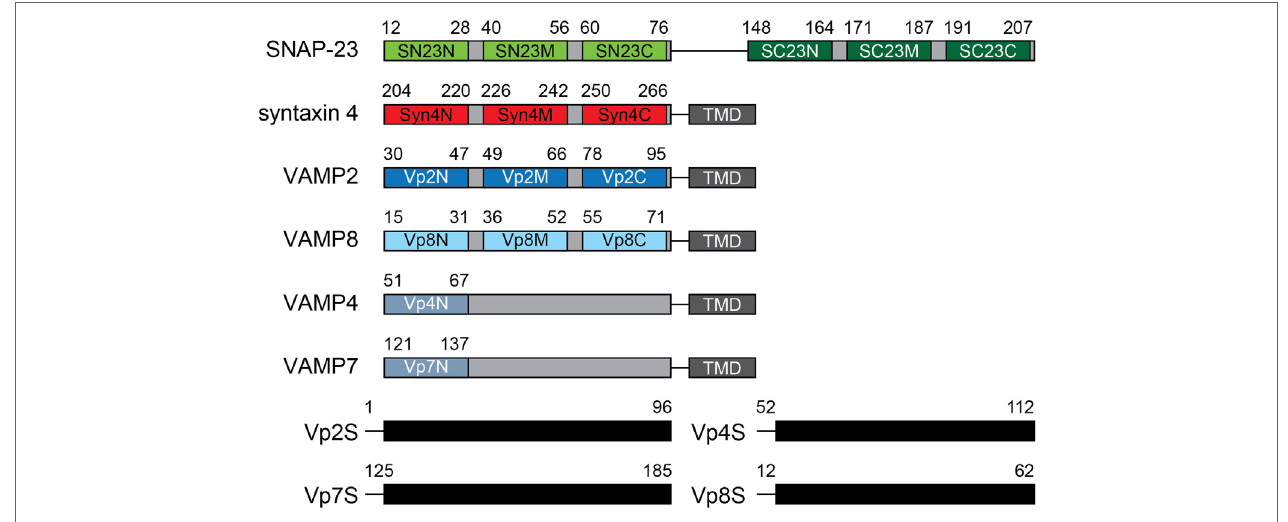
FigUre 1 | Design of mast cell soluble N -ethylmaleimide-sensitive factor attachment protein receptor (SNARE) motif-patterned peptides. Peptides patterned after the α -helical regions of the SNARE motifs of SN23 (green), syntaxin 4 (red), and VAMPs (blue) were designed. The names of the peptides are shown in the motif diagram, and the residue number in the motif corresponding to each peptide is indicated above each diagram. The amino acid sequences of the synthetic peptides are shown in Table 1 . The soluble domains of various VAMP proteins are also indicated. TMD, transmembrane